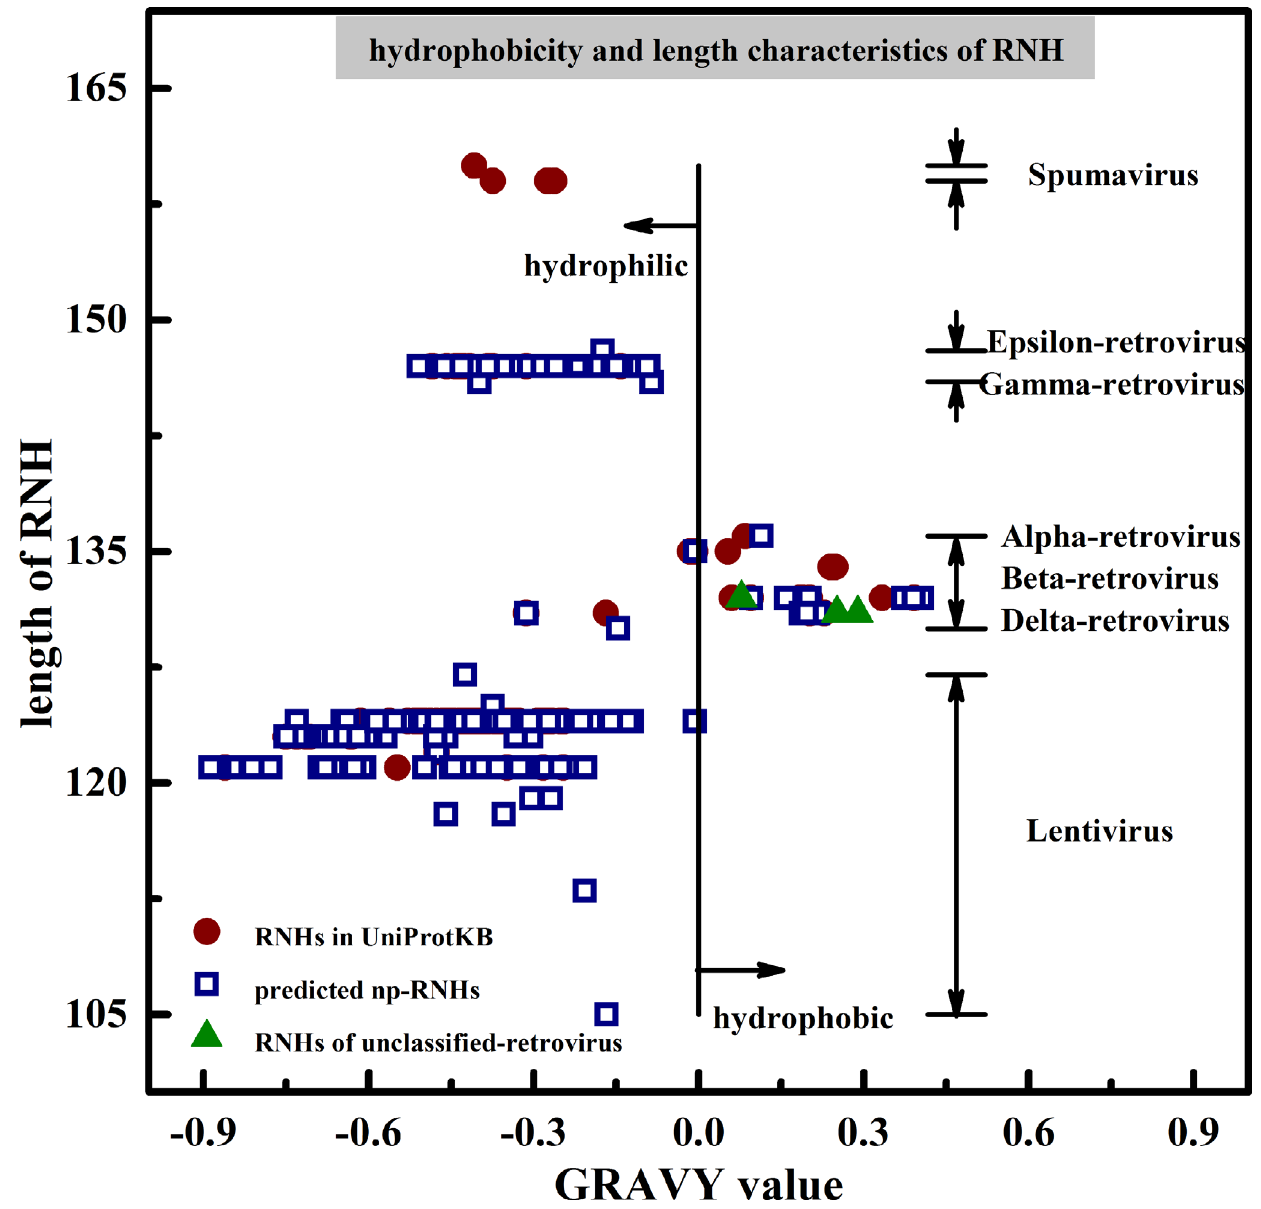
Fig 4. Hydrophobicity and length characteristics analyzed on RNH domains. RNHs in lentivirus are hydrophilic whose lengths range from 105 AA to 127 AA, RNHs in alpha-retrovirus, beta-retrovirus and delta-retrovirus are hydrophilic or hydrophobic whose lengths range from 130 AA to 136 AA, RNHs in epsilon-retrovirus and gamma-retrovirus are hydrophilic whose lengths range from 146 AA to 148 AA, while RNHs in spumavirus are hydrophilic whose lengths range from 159 AA to 160